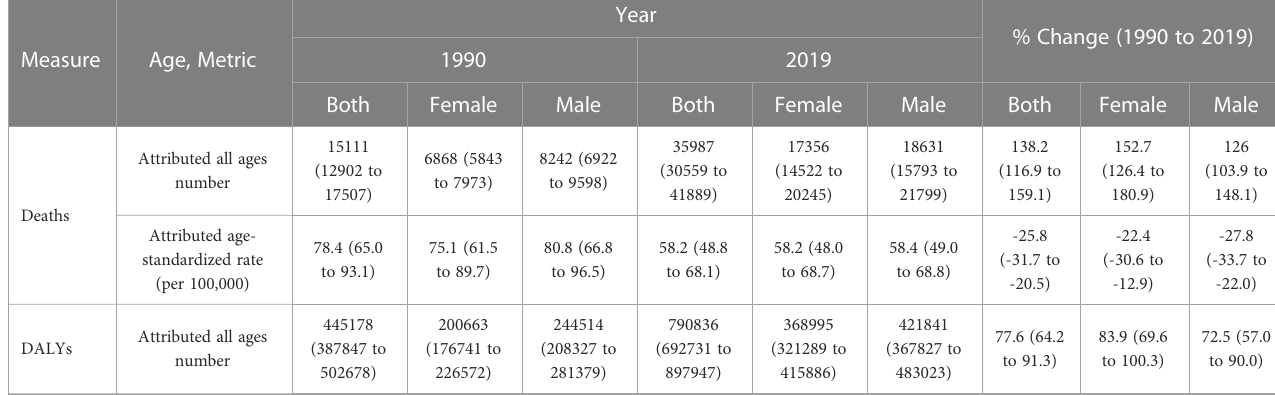
TABLE 1 Number and age-standardized rates of deaths, disability-adjusted-life-years (DALYs), years of life lost (YLLs), and years lived with disability (YLDs) attributable to kidney dysfunction in 1990 and 2019 and the overall percentage changes from 1990-2019 in Iran.